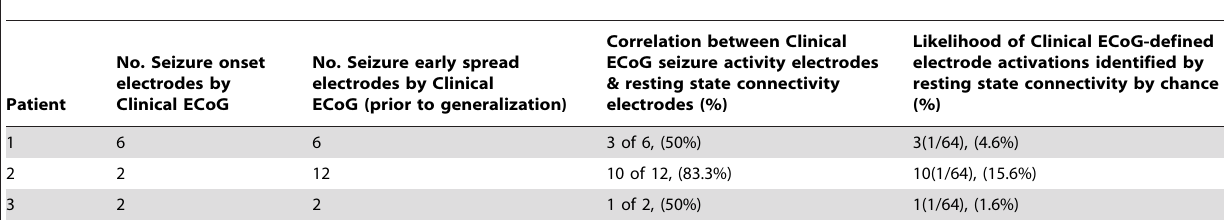
Table 2. Relationship Between Clinical ECoG Interpretation & Resting State Connectivity by ECoG Covariance Analyisis.